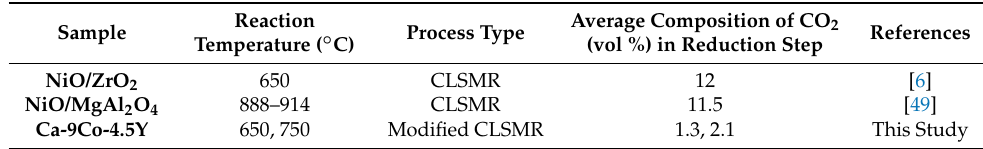
Table 2. Comparison of CO 2 volume percentage in the product stream.